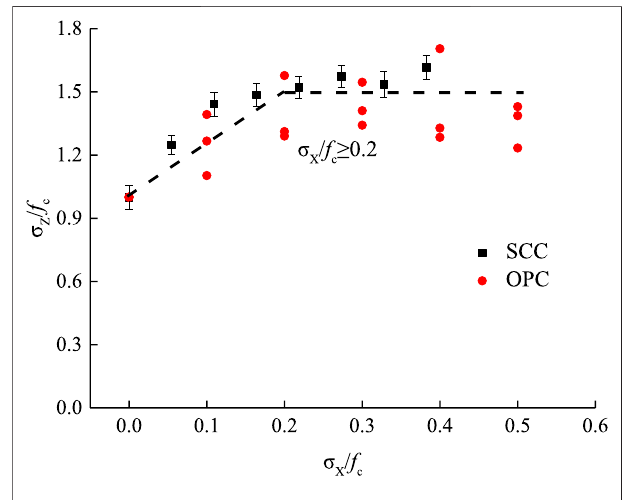
FIGURE 11 | The ratio of principal compressive stress and the ratio of lateral compressive stress of